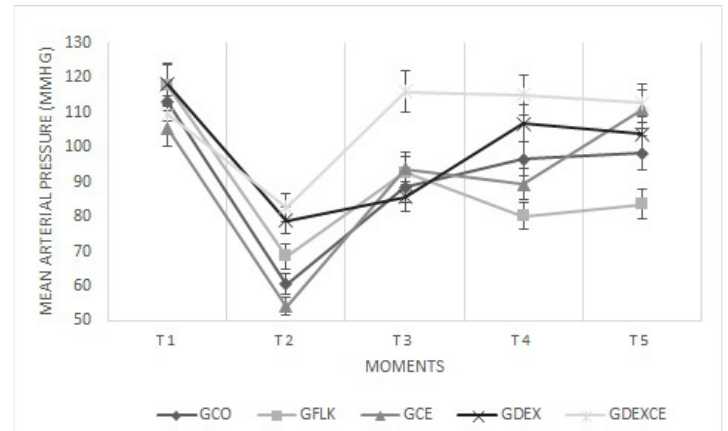
Figure 4. Mean Arterial Pressure (mmHg) relative to the groups and moments under study (before PAM, after anesthetic induction (GCO) and/or drug administration to reach the serum level (GFLK, GCE, GDEX, GDEXCE), during skin incision, during clamping of the ovarian pedicle, and immediately after extubation. The results of the Melbourne pain scale (Figure 5) show a significantly lower average for this variable in the groups GDEX and GDEXCE. In this assessment, GDEX results were compared with those of the GFLK, and the GDEXCE group showed better analgesic response than the groups GCO, GCE, and GFLK, according to the averages obtained.